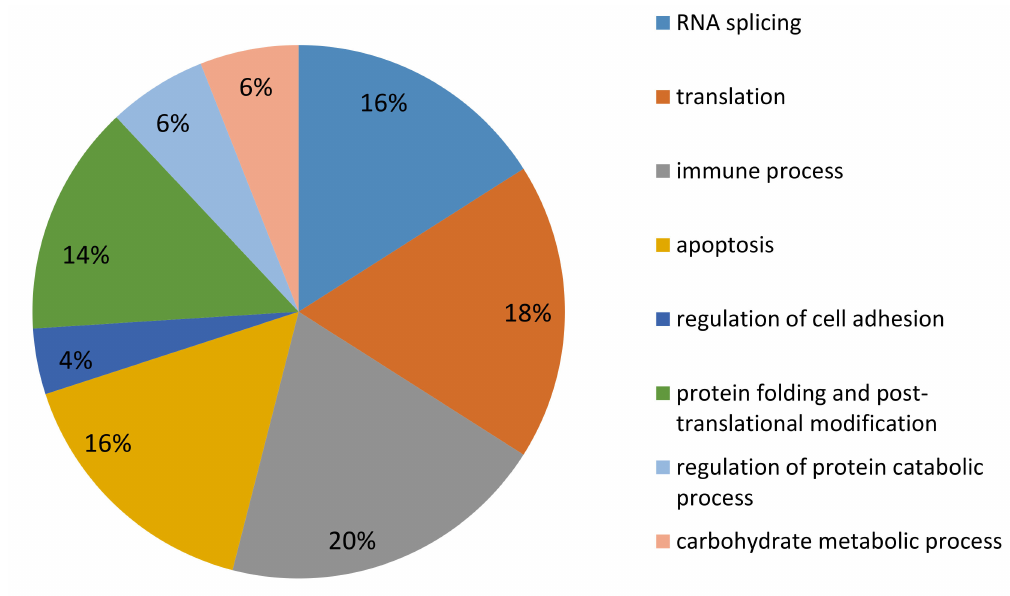
Figure 3. Main biological processes of differentially expressed proteins in MG of underfed (REST) versus control (CONT) early lactation cows during acute inflammation. Each percentage was indicated for each biological processes. Bioinformatics analyses were performed using Uniprot and Pathway Studio ®